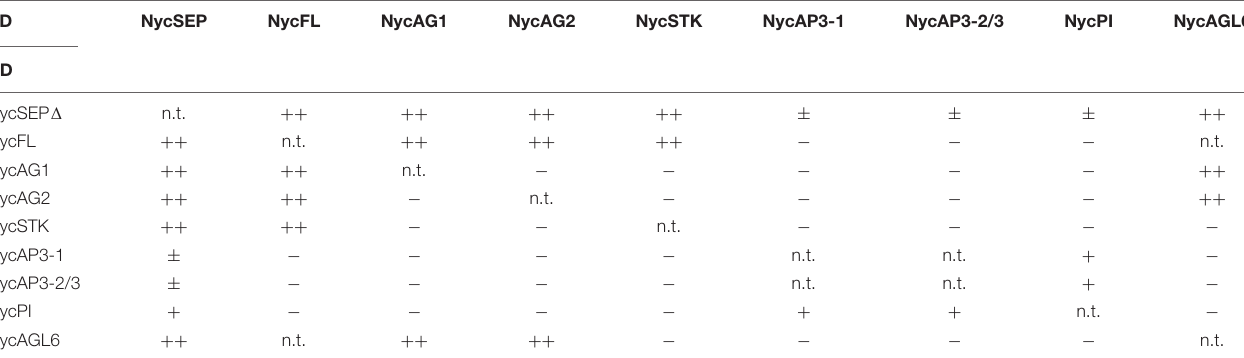
TABLE 1 | Results of yeast two-hybrid assays for N. caerulea MADS-domain